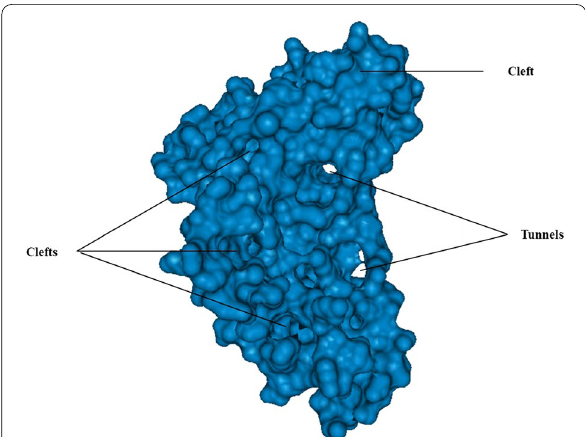
Fig. 8 Surface representation of the 3D Y-domain structure of HEV. The overall shape of the protein is irregular having several clefts and